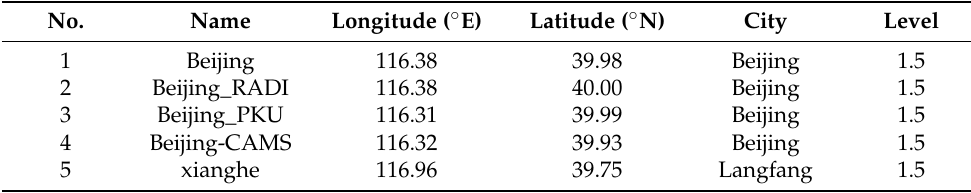
Table 1. Information about AERONET sites used in this